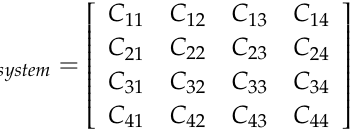
Figure 5. Schematic diagram of two pairs of capacitor electrodes.